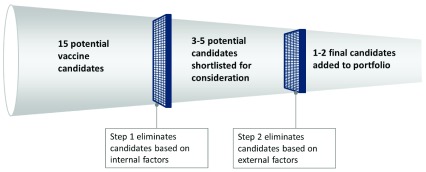
Evaluation framework.The figure captures the underlying principles and working of the evaluation framework by identifying two primary filters applied as a part of the process.